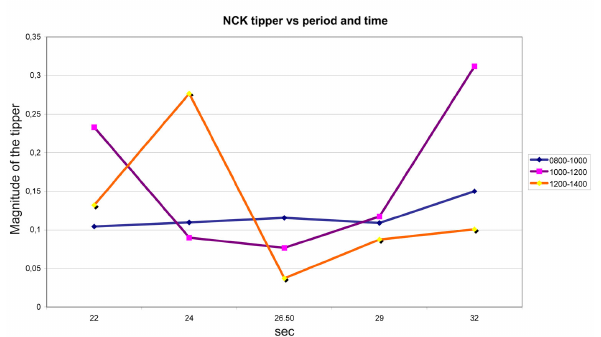
Fig. 10. NCK real tippers at FLR periods (22, 24, 26.5s) in 30-min sections, 08:00–14:00 UT.